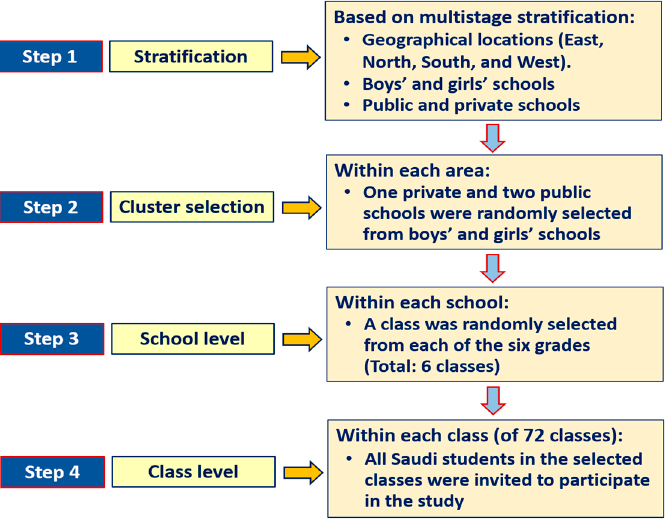
Figure 1. The protocol used for participants’ selection.